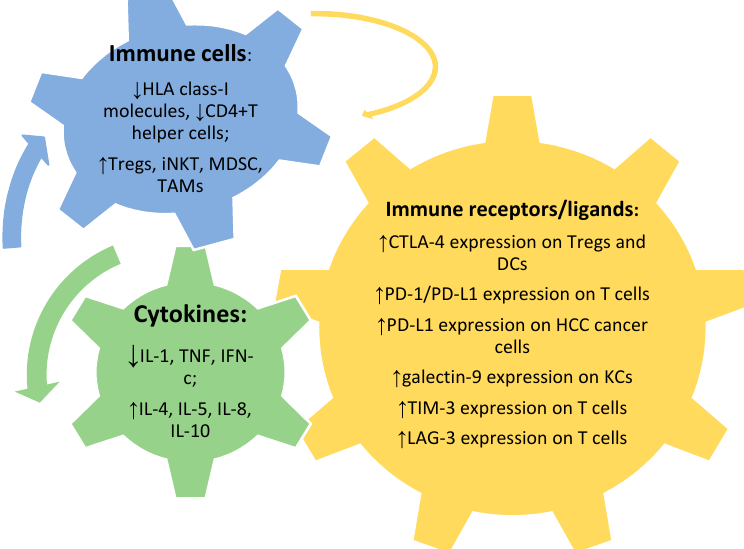
Figure 2. In addition to the tolerogenic hepatic environment, multiple players can contribute to immune evasion in HCC: immune cells, cytokines, immune receptors or ligands. Abbreviations: human leukocyte antigen (HLA); regulatory T cells (Tregs); invariant natural killer T cells (iNKT); myeloid-derived suppressor cells (MDSC); tumor-associated macrophages (TAMs); cytotoxic T-lymphocyte antigen 4 (CTLA-4); dendritic cells (DCs); programmed death-1 (PD-1); programmed death-ligand 1 (PD-L1); T-cell immunoglobulin and mucin domain-containing protein 3 (TIM-3); Lymphocyte-activation gene 3 (LAG-3); interleukin (IL); tumor necrosis factor (TNF); interferon